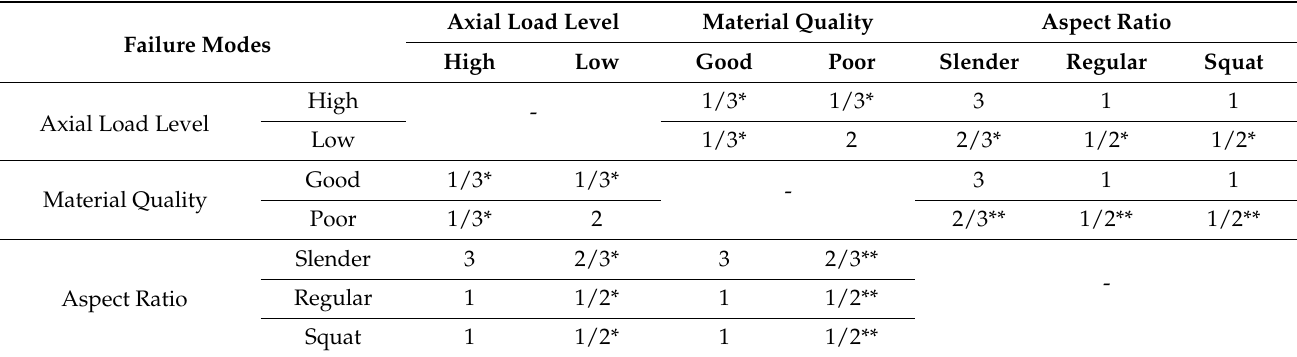
Table 1. Set of rules to estimate failure modes of URM